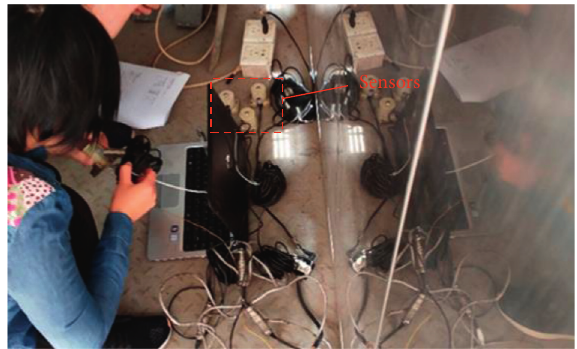
Figure 4: Arrangement of sensors in the carriage.